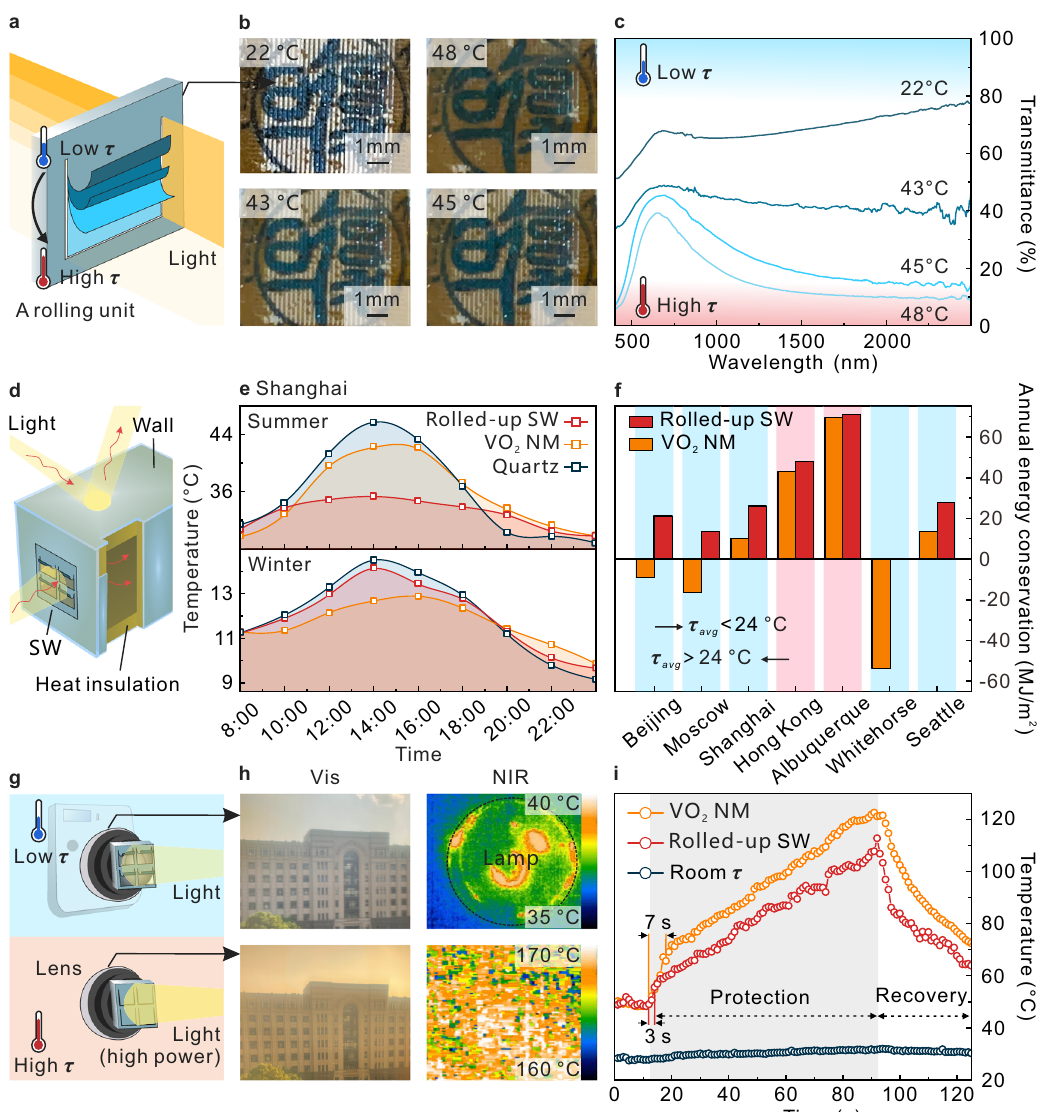
Fig.5|Rolled-upSWforenergysavingandlensprotection.a Schematicofmulti- level light control by different temperatures. b Photograph of rolled-up SW at different temperatures. c Transmittance spectra of the rolled-up SW at different temperatures. d Schematic of the house model for the rolled-up VO 2 SW demo. e The daily indoor temperature modulation of different seasons in Shanghai by using different windows. f Annual energy conservation with different windows compared to the normal glass window in 7 cities. The blue areas indicate that the